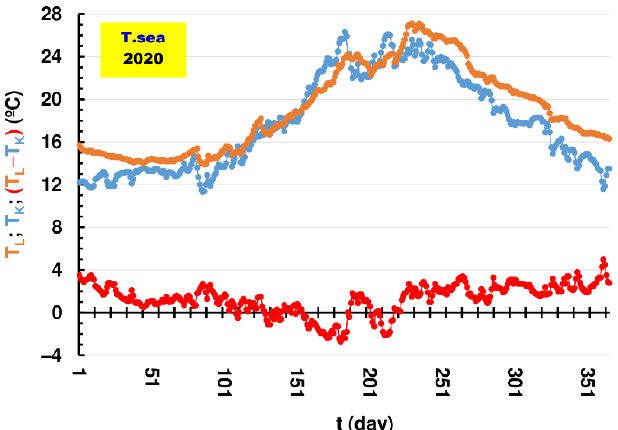
Figure 12. Time series of the mean daily sea surface temperatures at Lastovo (brown) and Krk (blue) and their differences (red) observed during 366 days in 2020.